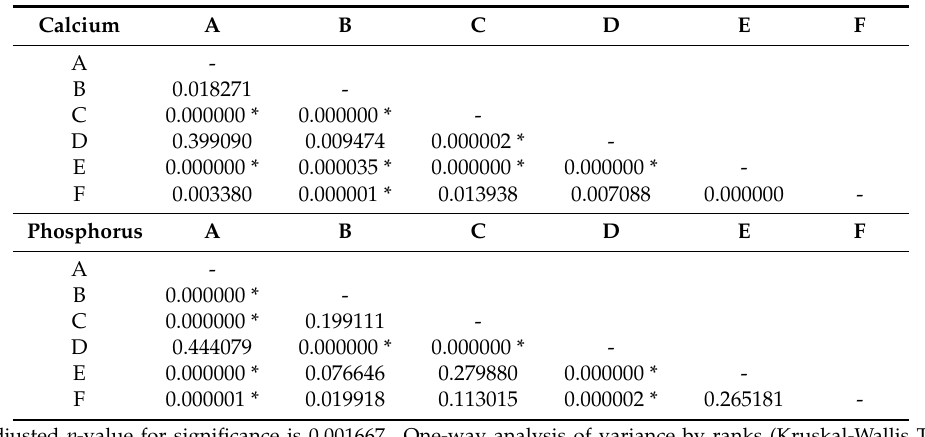
Table 2. Analysis of calcium and phosphorus ion content in solution after the use of remineralizing agents.